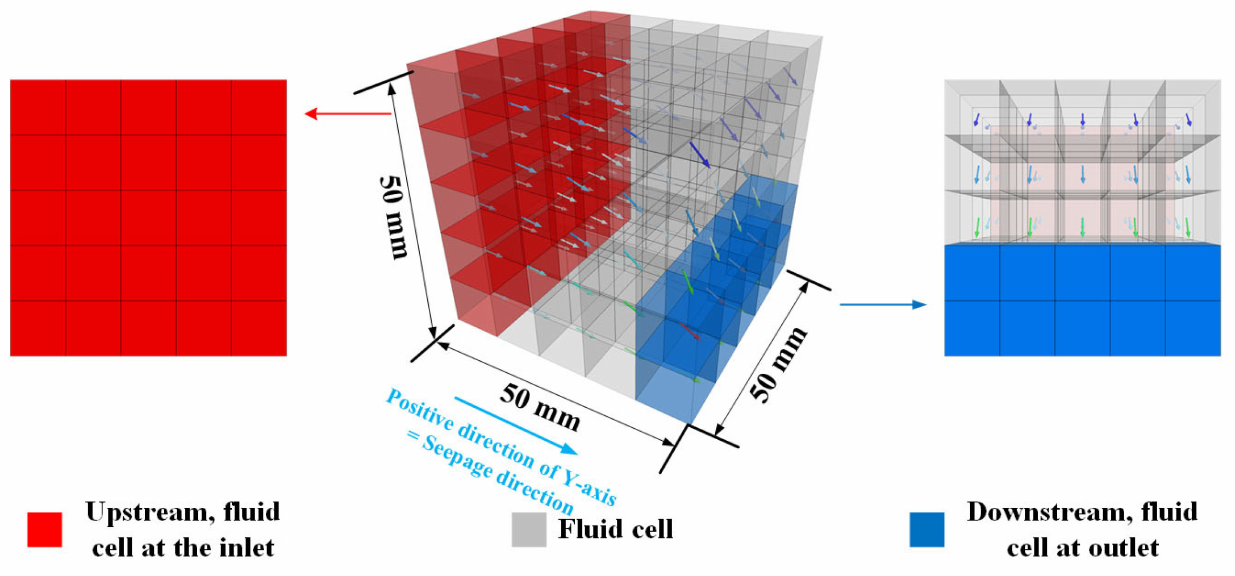
Figure 6. Implementation of the fluid field for two-way coupling (arrows denote the flow direction of each fluid